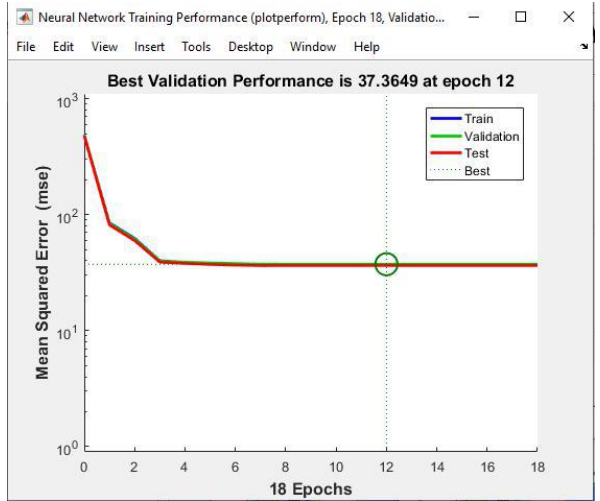
Figure 6 . best validation performance is at epoch 12 and 37.3649 where the exact solution obtains MSE is the mean (average) magnitude of the squares of the error: i.e., the distance between the model's estimate of your test values and the actual test value. (Squaring just converts things to an absolute value rather than fiddling with under or overshooting).